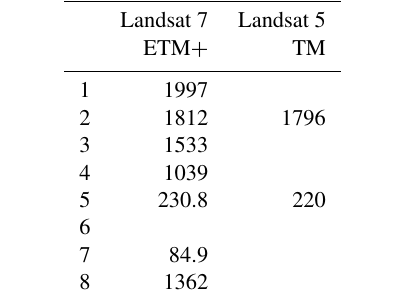
Table A1. Exoatmospheric solar constant per band for ETM + and TM sensors (Chander et al.,